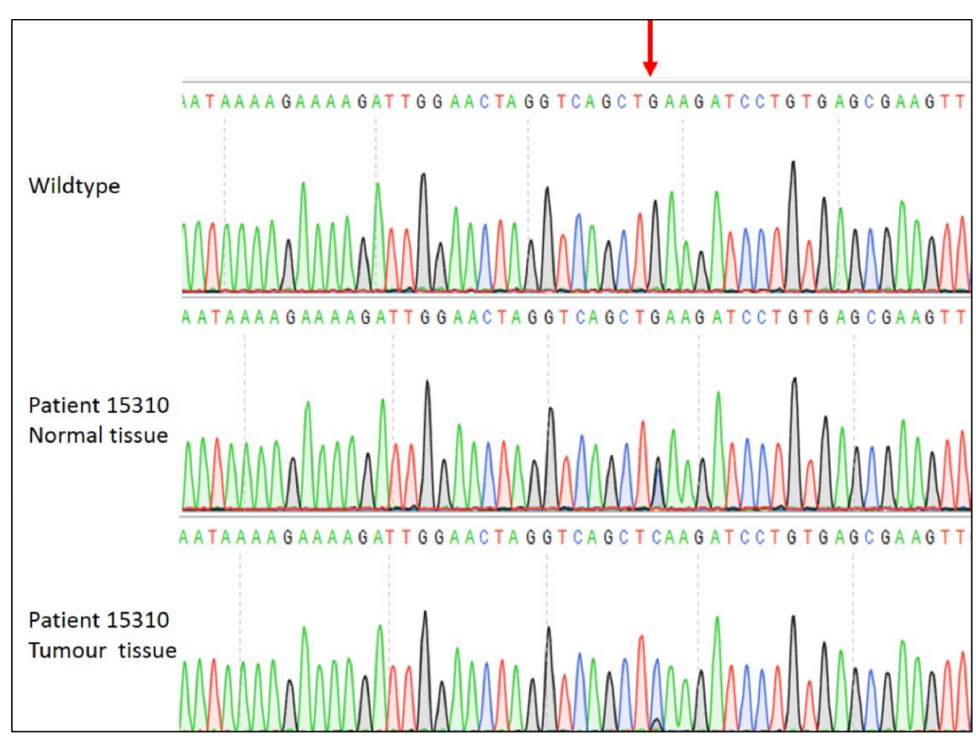
Figure 1. Sanger sequencing of APC c.3949G>C mutation. The guanine base indicated by the red arrow in the wild type APC sequence is mutated to a cytosine in one allele in the normal tissue of the patient